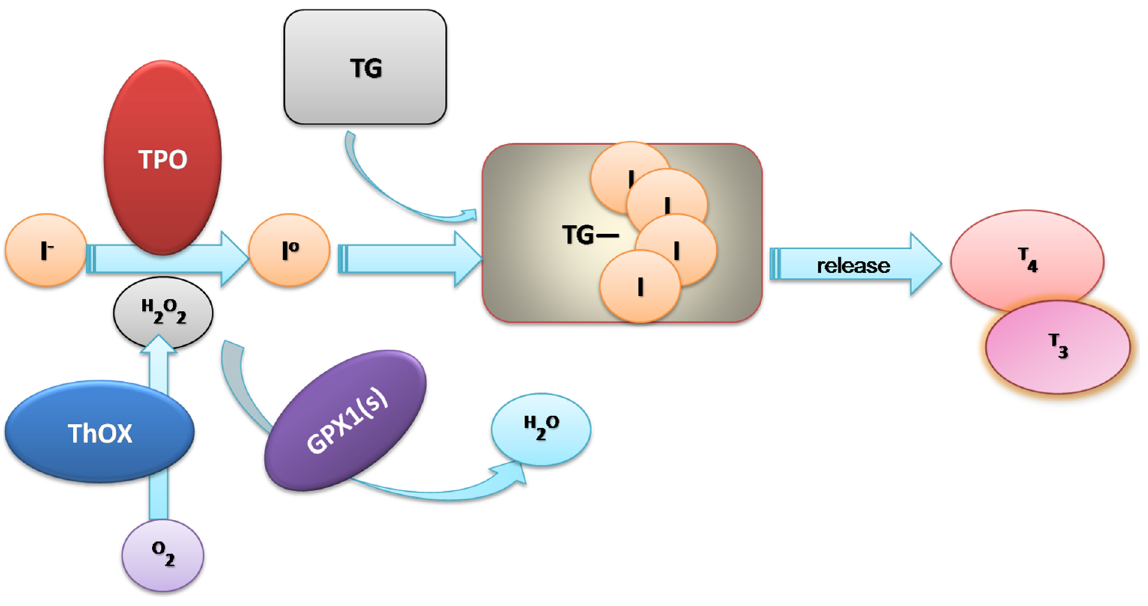
Figure 2. Iodine and GPXs involved in Thyroid Hormones Biosynthesis. The serum sodium iodide is transported into the thyrocyte and then iodine is incorporated into the thyroglobulin molecule (Tg) in a reaction catalyzed by the hemoprotein thyroid peroxidase (TPO). In this reaction, H 2 O 2 generated by the NADPH-dependent thyroxidase (ThOx) is required as substrate by TPO for the iodination and coupling of tyrosyl residues in Tg. Then, thyroid hormones triiodothyronine (T3) and tetraiodothyronine (T4) are released into the bloodstream. H 2 O 2 used in this reaction decreases the amount of H 2 O 2 that would otherwise be available for damaging oxidation reactions. Selenium-dependent glutathione peroxidase 1 ( GPX 1 ) and other GPX s remove H 2 O 2 from the tissues, also decreasing oxidative damage. (Modified from: J. Ko¨hrle et al . Selenium, the thyroid, and the endocrine system. Endocrine Reviews, December 2005, 26(7):944–984; Lyn Patrick, ND. Iodine: deficiency and therapeutic considerations. Alternative Medicine Review, 2008,